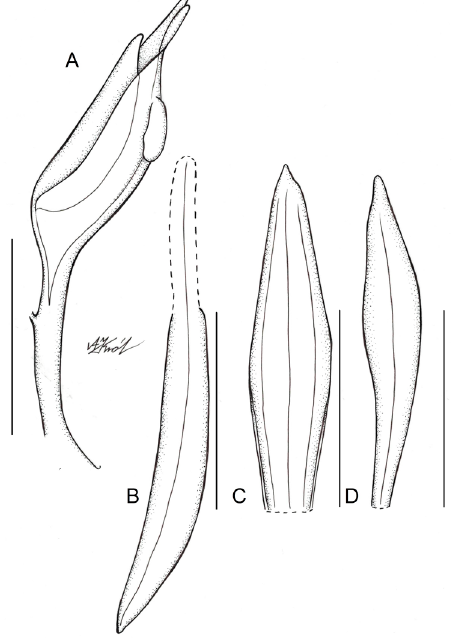
Figure 5. Floral parts of Schiedeella bajaverapacensis: ( A ) gynostemium—side view; ( B ) lateral sepal; ( C ) dorsal sepal; ( D ) petal. Scale bars—5 mm. Drawn from the holotype by A. Król. TYPE: GUATEMALA. Departamento de Baja Verapaz. Municipio de Salamá, a 950